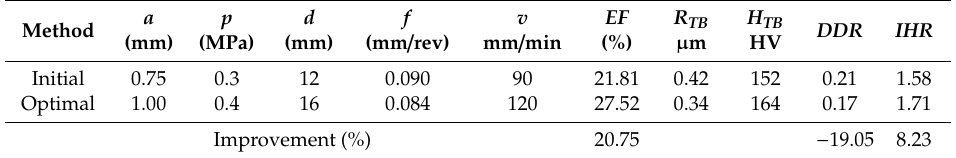
Table 11. The optimum